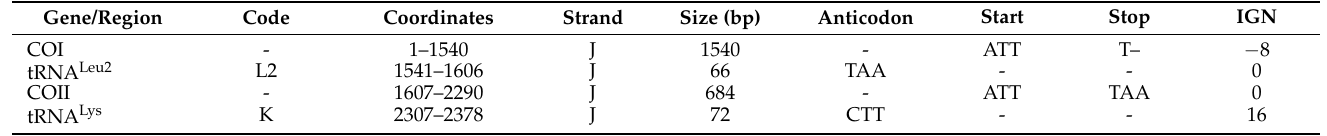
Table 2. List of specimens of Anchonocranus oleae (Coleoptera: Curculionidae) used for DNA analyses (barcoding and sequencing of complete mitochondrial genome) and photographic imaging and deposition in the insect collection of the Iziko Museum of South Africa (Cape Town).